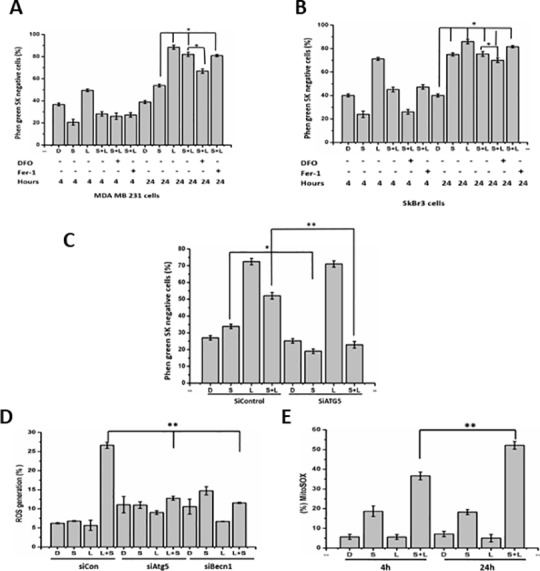
Siramesine and lapatinib increase iron level and ROS generation.(A, B) The effects of DFO (0.5mM) and ferrostain-1 (5 microM) on intracellular chelatable iron under siramesine and lapatinib treatment in MDA MB 231 and SKBR3 cells for 4 and 24 hours respectively. Intracellular chelatable iron was determined using the fluorescent indicator phen green SK, the fluorescence of which is quenched by iron. Samples were examined using a BD FACS Calibur. (C) Effects of knockdown of Atg5 on siramesine and lapatinib-induced intracellular chelatable iron at 24 hour in MDA MB 231 cells. (D) Effects of knockdown of Atg5 or Becn1 on siramesine and lapatinib-induced ROS generation at 24 hour in MDA MB 231 cells. (E) The effect of siramesine and lapatinib on mitochondrial ROS generation. Mitochondrial ROS was determined using the fluorescent indicator mitoSOX, samples were examined using a BD FACSCalibur. These results were representative of three independent experiments (n = 3), *p<0.05; **p<0.01.